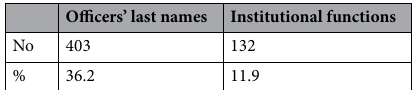
Table 2. BTT with different naming